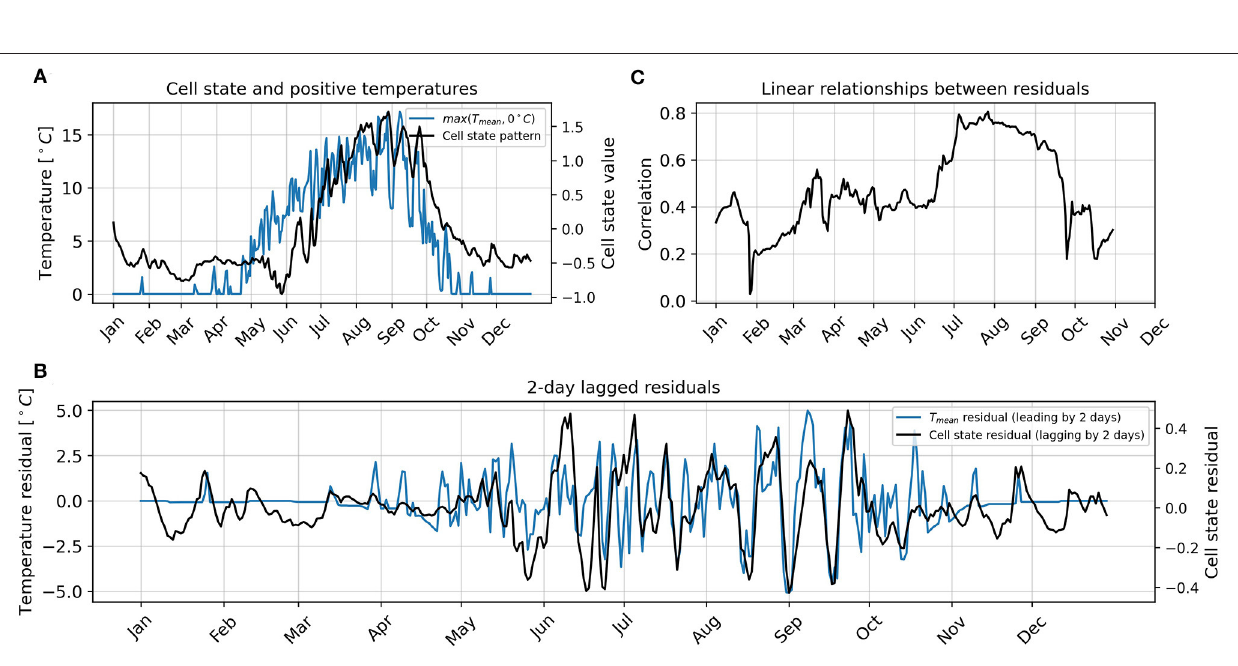
different streamflow regimes. Nival and glacial basins